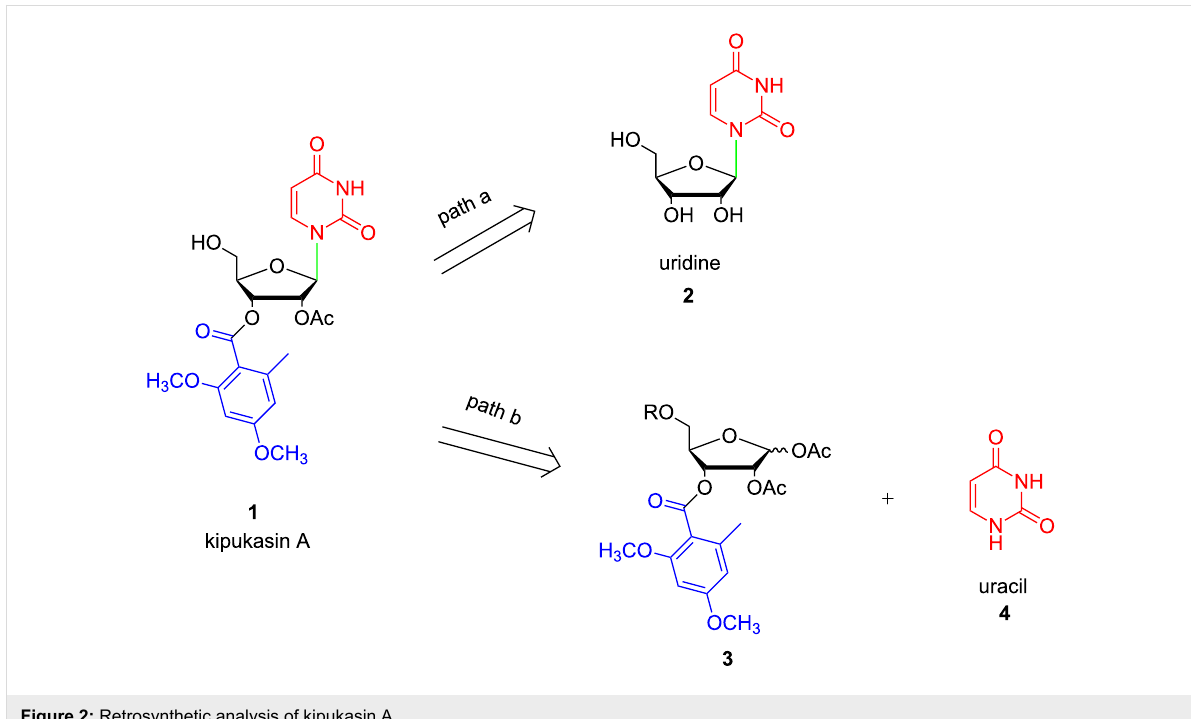
Figure 2: Retrosynthetic analysis of kipukasin A.